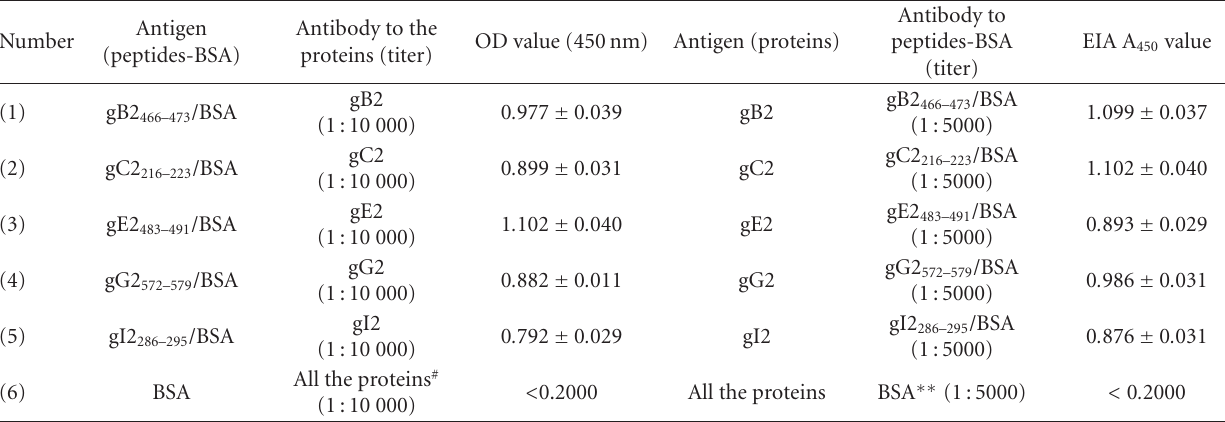
Table 2: Antigenicity and specificity analysis of the five epitopes using